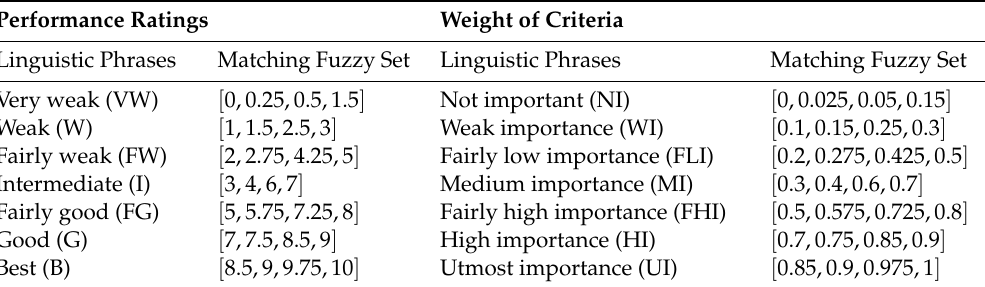
Table 2. The linguistic terms and corresponding trapezoidal fuzzy numbers .